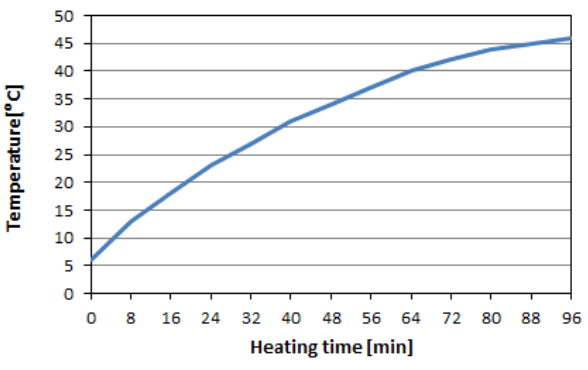
Fig. 6. Coolant temperature as a function of heater on time